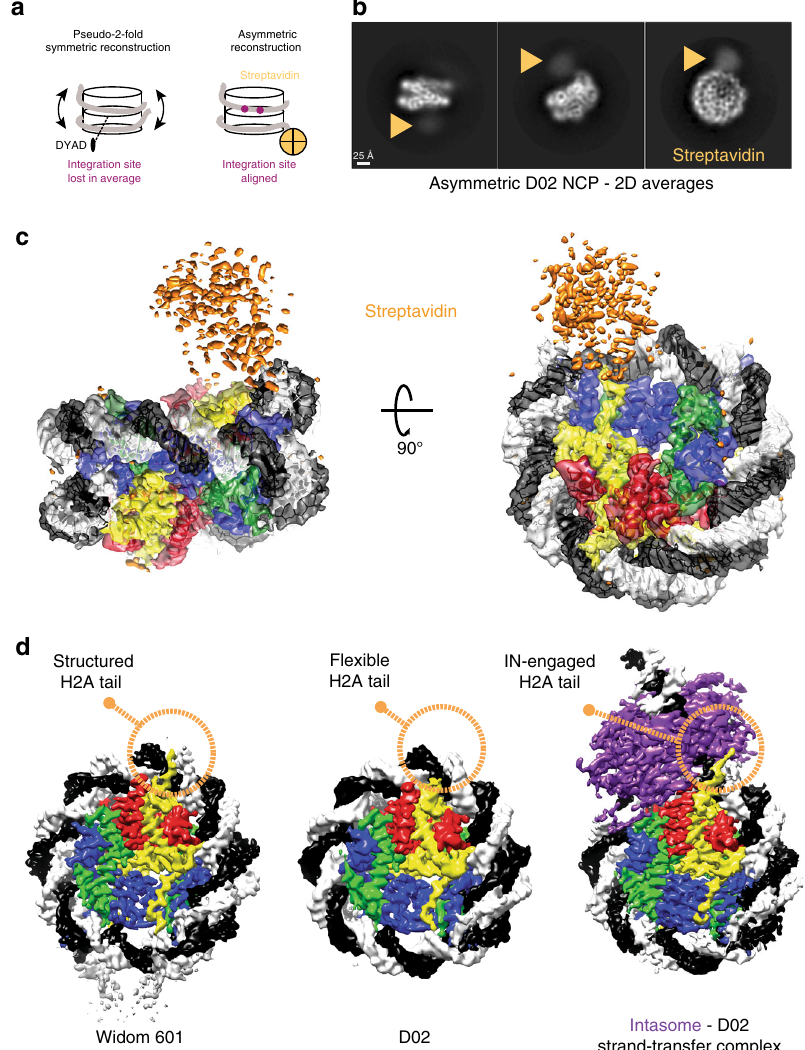
Fig. 3 Asymmetric reconstruction of the isolated D02 NCP. a Streptavidin labelling allows asymmetric reconstruction of the D02 NCP, which avoids pseudo-two-fold symmetry averaging of the integration-site DNA. b 2D averages of labelled D02 NCP particles reveal a discernible, diffuse density for streptavidin at the nucleosomal DNA arm distal from the integration site. c 3D reconstruction of D02 NCP reveals an asymmetric streptavidin label decorating one of two nucleosomal DNA arms. d Unlike for Widom 601, the D02 NCP contains limited density for the N-terminal H2A tail, indicating that this element is fl exible and available for intasome engagement. In fact, in the Intasome-NCP strand-transfer complex the N-terminal H2A tail interacts with IN, stabilising the interaction (also see Fig. 2b,